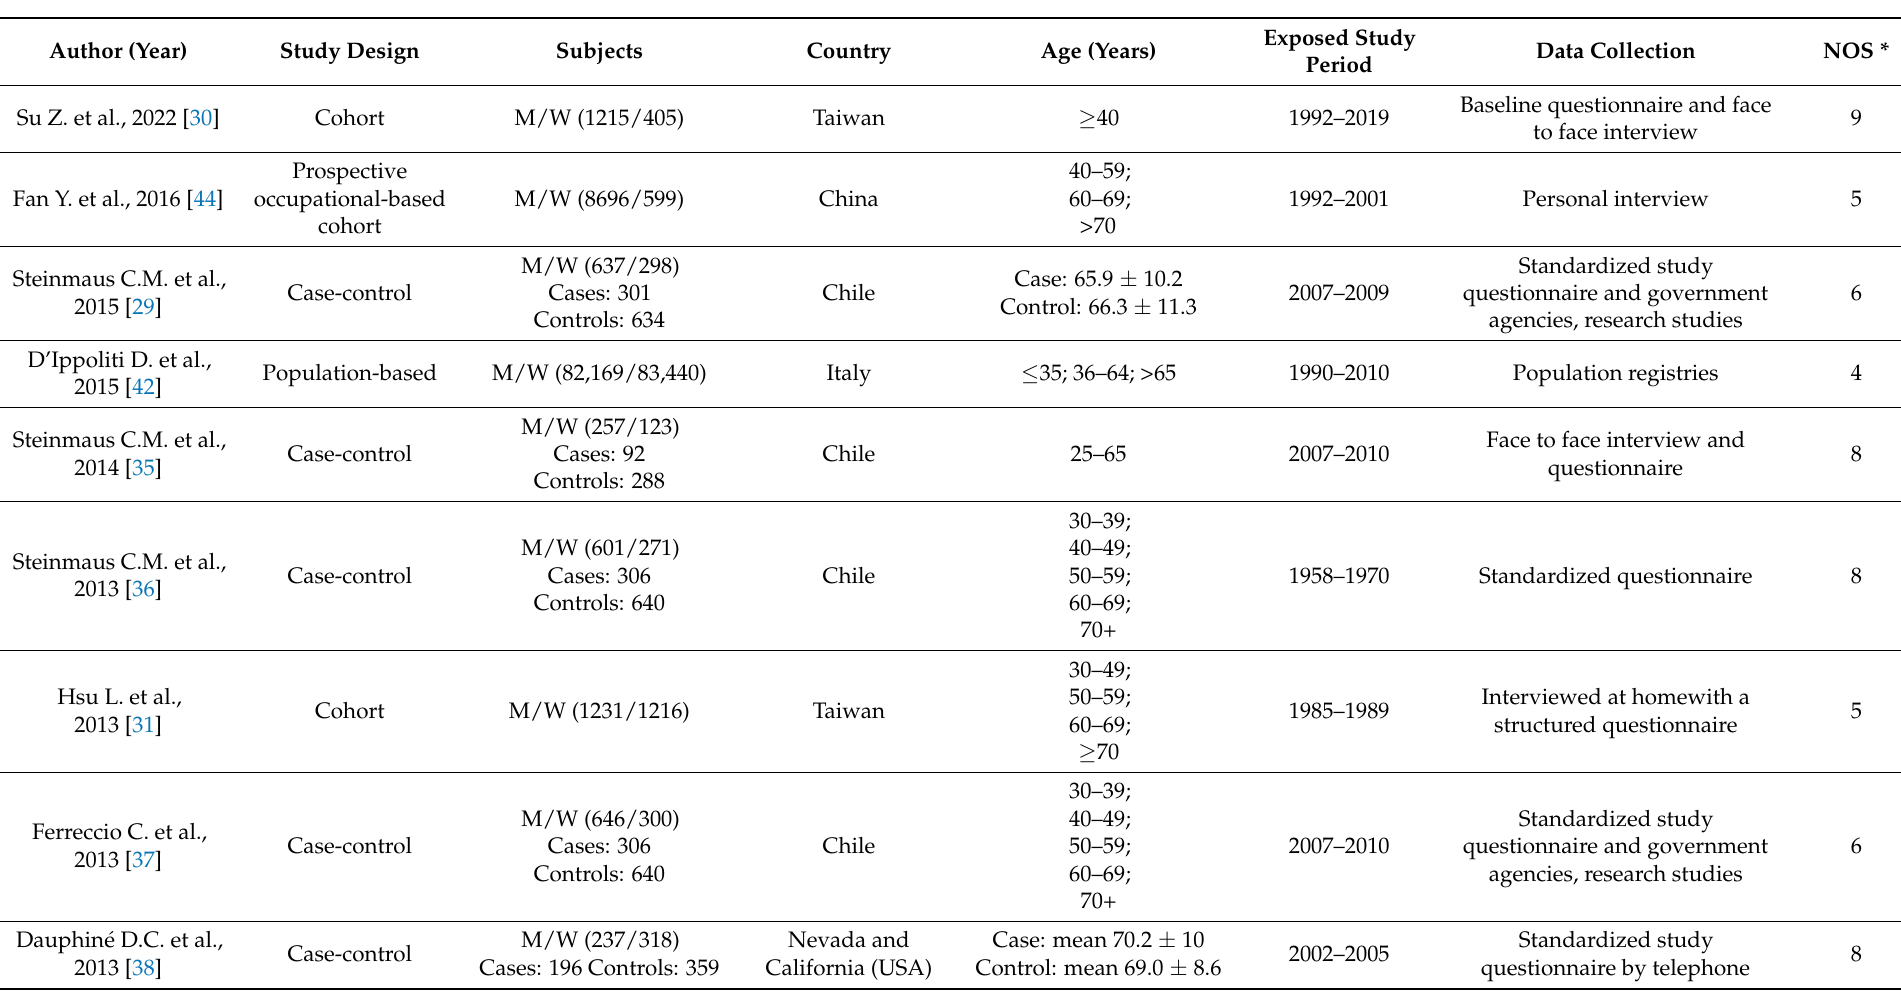
Table 1. Characteristics of the included